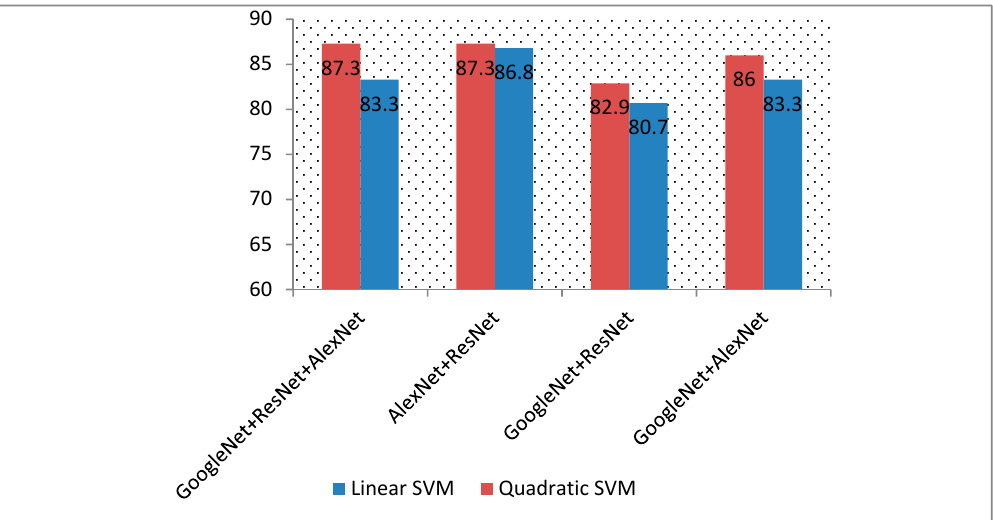
Figure 8. A comparision between the accuracies of different combinations of deep features extracted from different DCNNs.